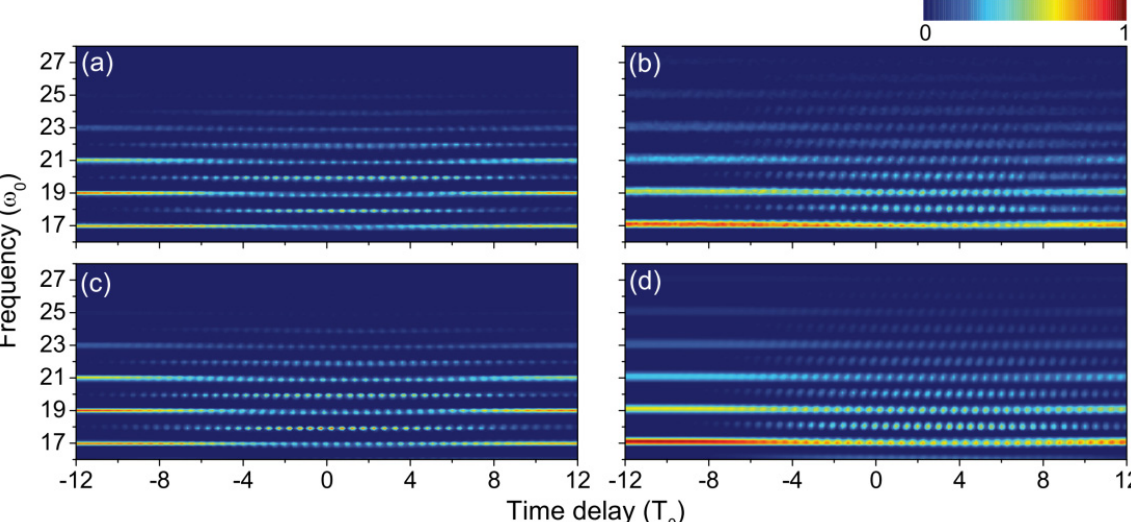
Figure 3. Photoelectron spectra of He ionized by attosecond harmonic pulses with a probe laser pulse. High harmonics were obtained with a driving laser at an intensity of ( a ) 1.6 (cid:3400) 10 (cid:2869)(cid:2872) W/cm (cid:2870) and ( b ) 3.2 (cid:3400) 10 (cid:2869)(cid:2872) W/cm (cid:2870) . The reconstructed spectra are shown in ( c ) and ( d ) for cases ( a ) and ( b ), respectively [22].